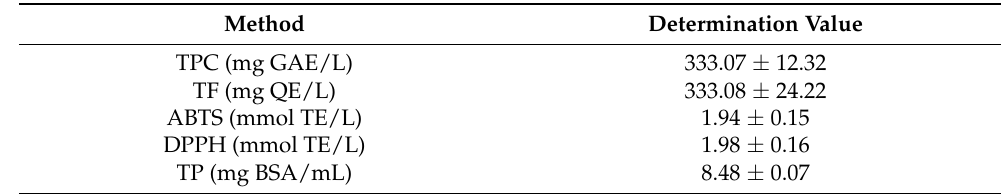
Table 2. Chemical properties of rosemary extract (the total polyphenolic content (TPC), total flavonoid content (TF), antioxidant capacity (ABTS and DPPH methods), and total protein content